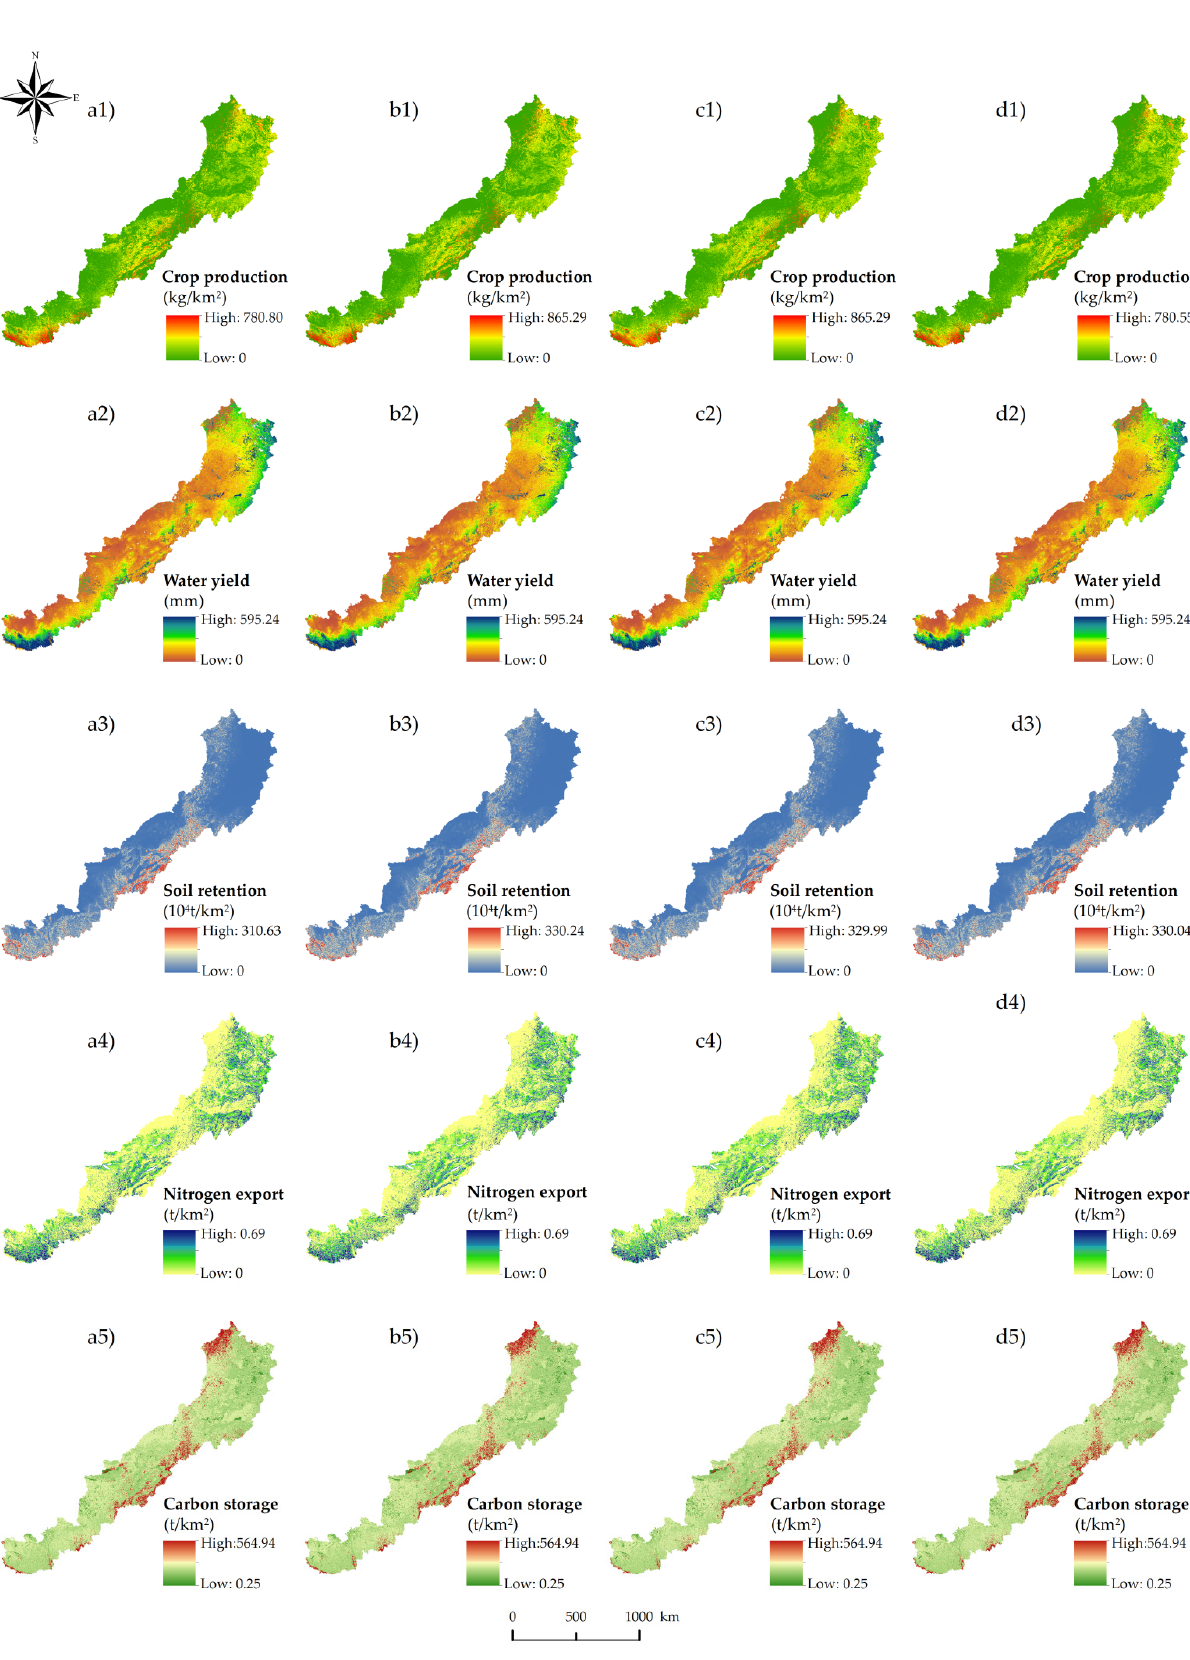
Figure 7. Ecosystem services in 2020 and the alternative future scenarios: ( a ) 2020; ( b ) BAUS; ( c ) EDS; ( d ) EPS.